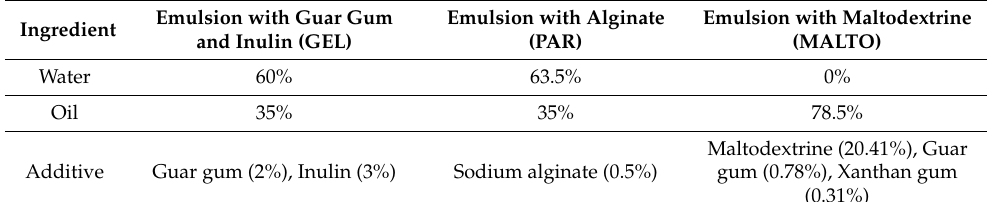
Table 1. Formulation of the three stable emulsions used to replace animal